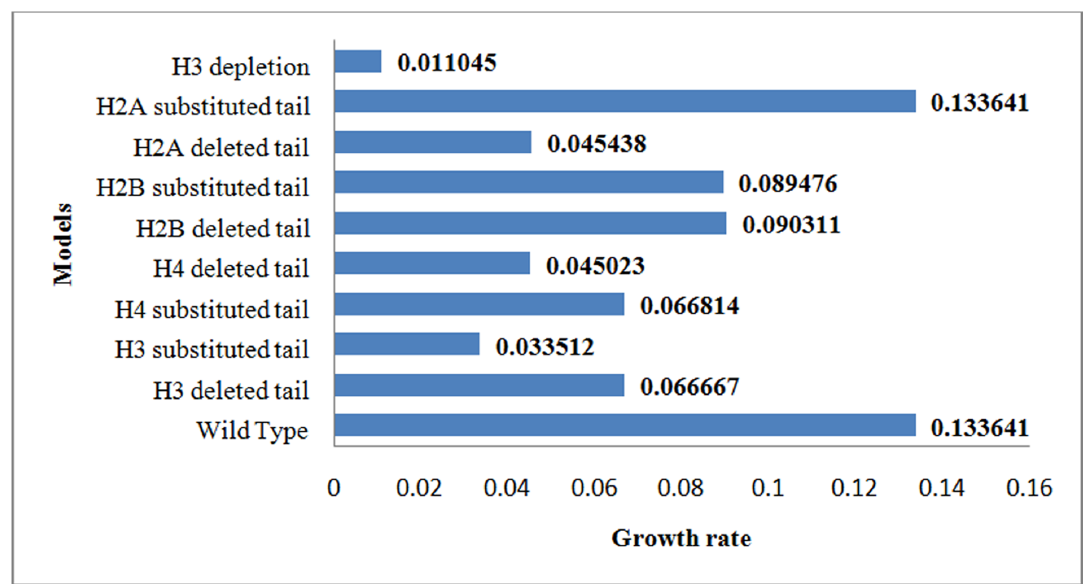
Figure 4. Shows the growth rate (the optimal objective value) of all constructed GSMMs calculated by FBA. The unit of the growth rate is mmol gDW 2 1 hr 2 1 (milimoles per gram dry cell weight per hour).